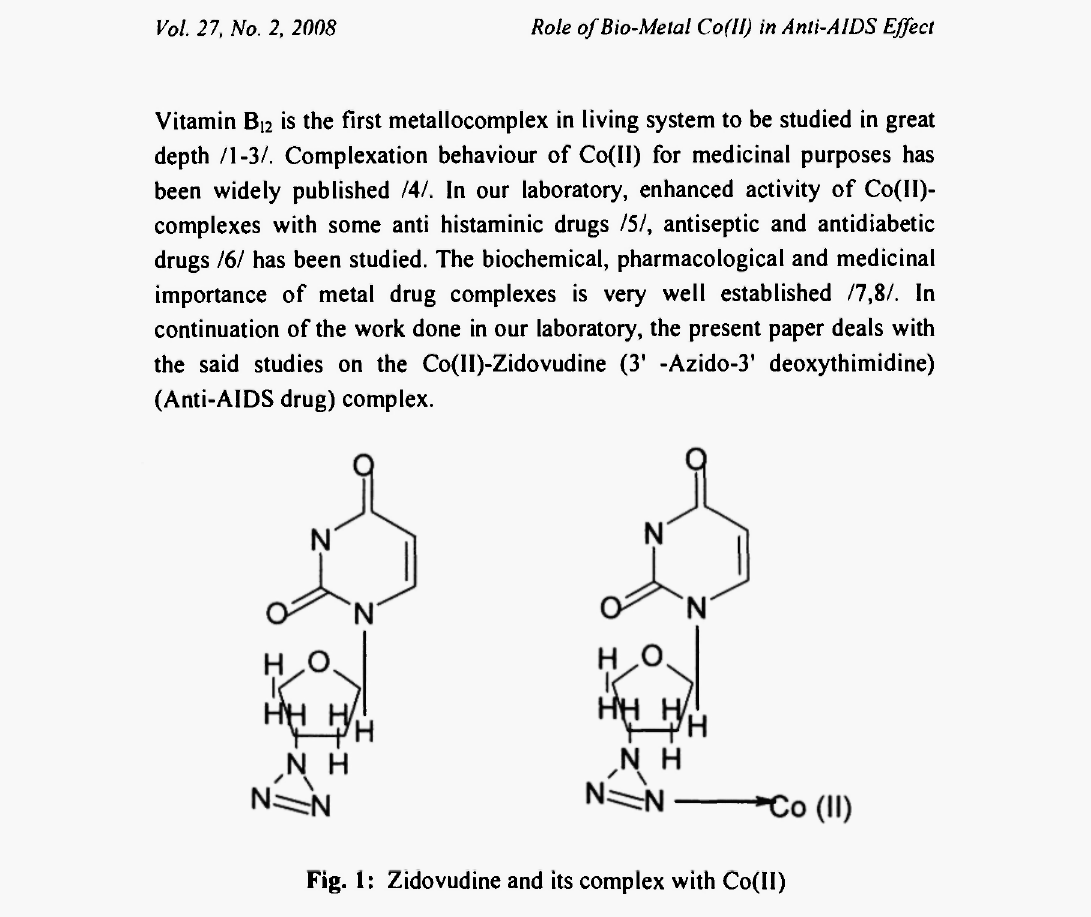
Fig. 1: Zidovudine and its complex with